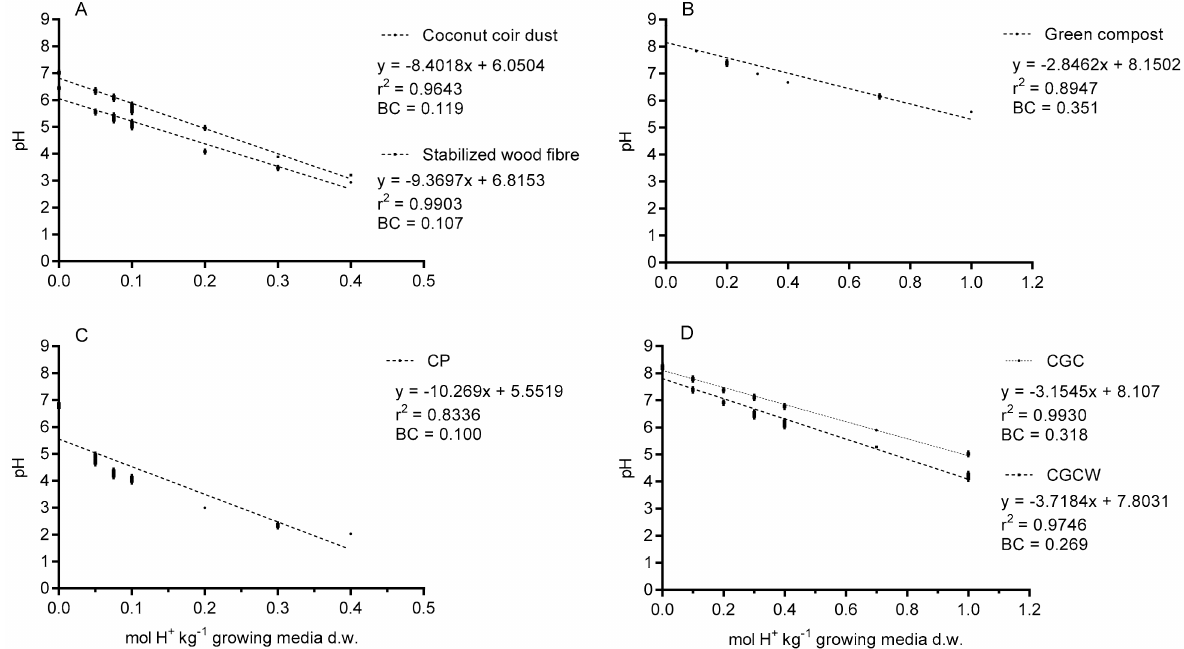
Figure 1. Determination of pH buffering capacity (BC) calculated as reported in Equation (1) and obtained at 72 h for: ( A ) coconut coir dust and woody fibre; ( B ) green compost; ( C ) coconut coir dust:pumice (CP); ( D ) coconut coir dust:green compost (CGC) and coconut coir dust:green compost:stabilized wood fibre (CGCW). d.w. is growing media dry weight. Values represent mean ± standard deviation calculated on three replicates. The linear regression equation is significant for p <